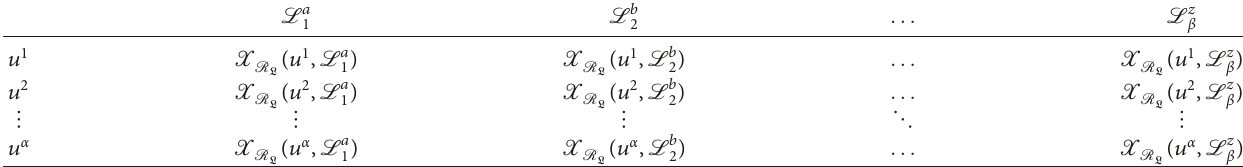
Table 2: Decision makers will assign neutrosophic numbers to each candidate T